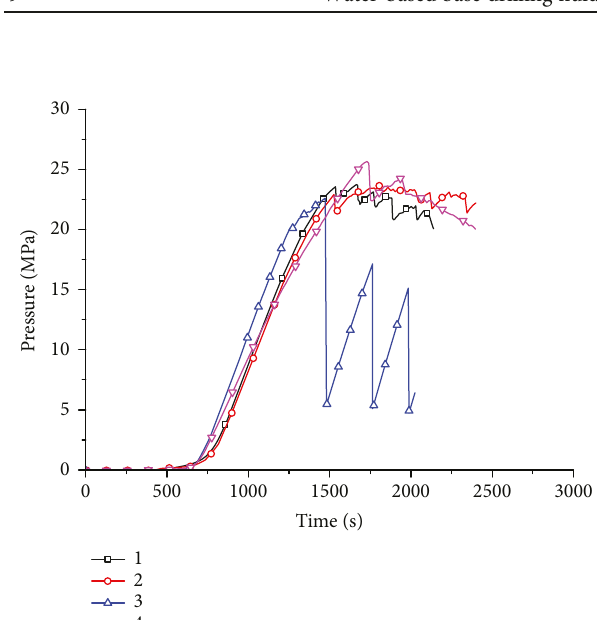
Figure 15: Pressure curves in the core fracturing